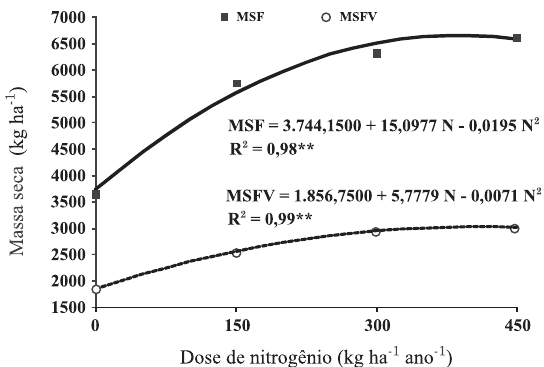
Figura 1. Produtividade média da massa seca total (msF) e da massa seca de folhas verdes (msFv) do Panicum maximum jacq. cv. iPR – 86 milênio, em função da adubação nitrogenada referente à média das safras 2007/08 e 2008/09. os símbolos ** indicam que os modelos ajustados foram significativos com F <